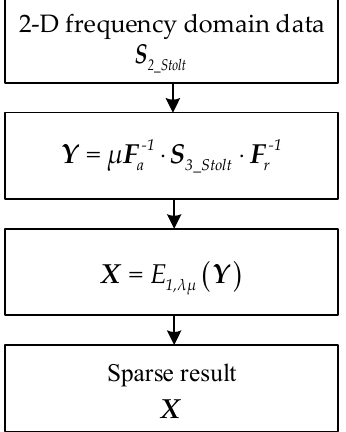
Figure 6. Algorithm flow of sparse enhancement.